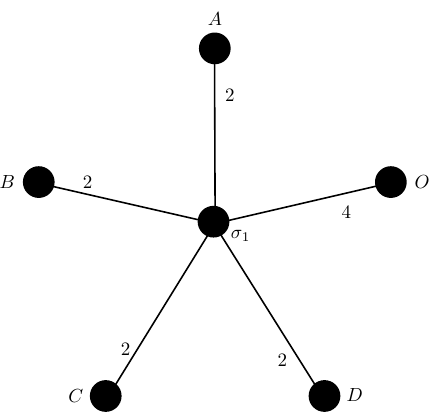
Figure 20 . A graph with four boundary vertices A, B, C, D and purifier O along with one internal vertices σ . Edge capacities are labeled for each 1